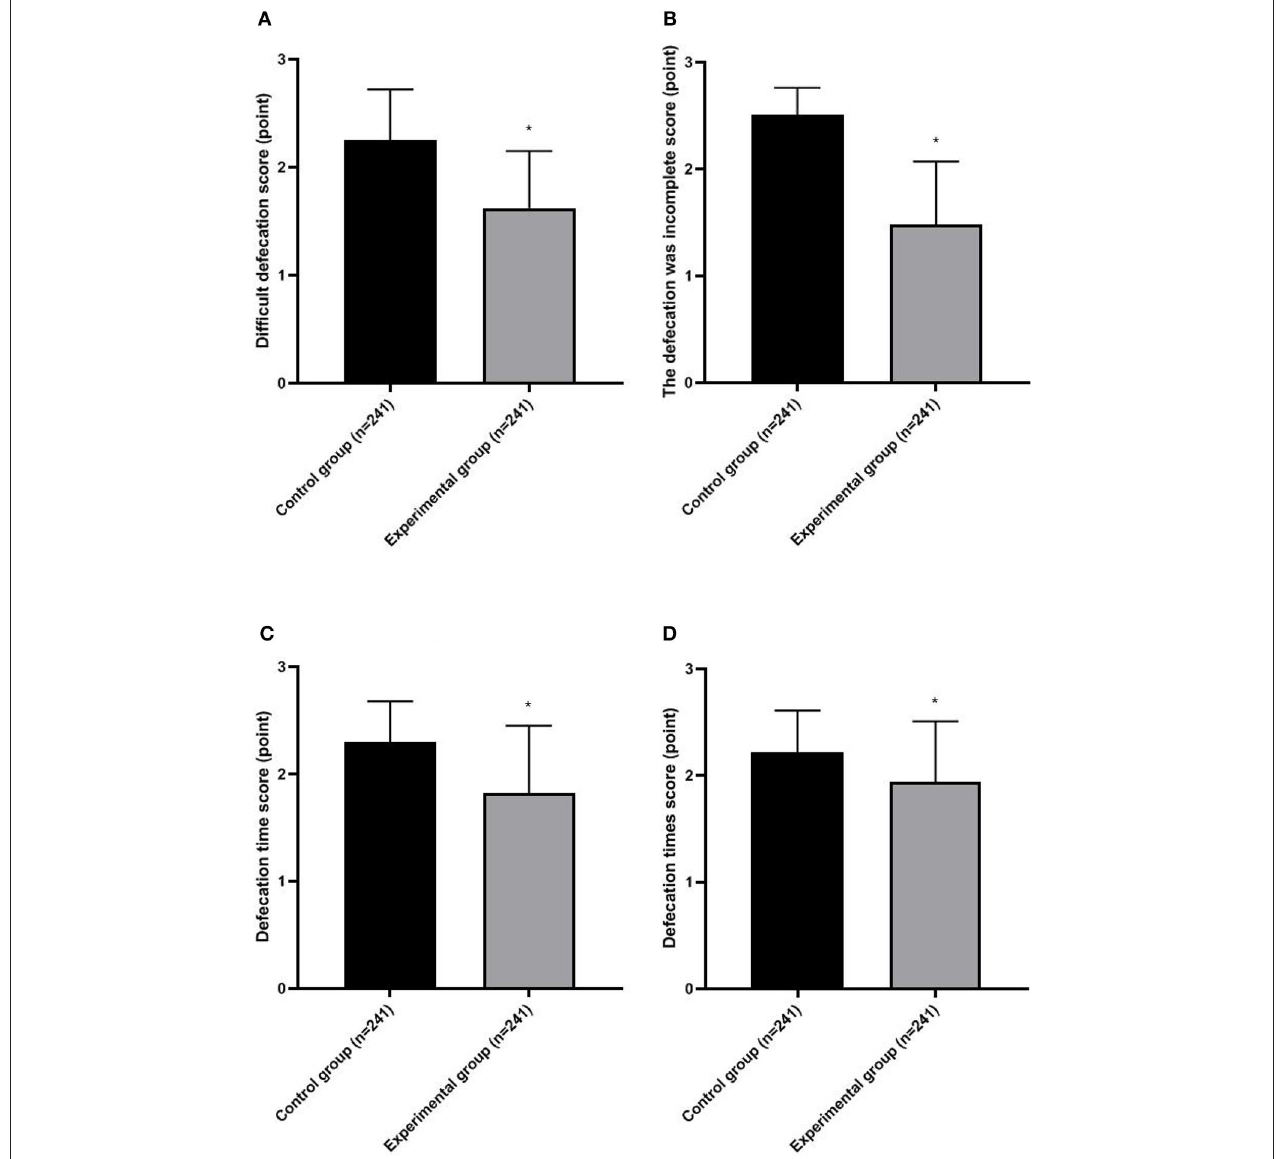
FIGURE 1 | Severity of constipation in two groups. (A) Difficulty defecation score; (B) The defecation was incomplete score; (C) Defecation time score; (D) Defecation times score. Compared with the control group, * p <